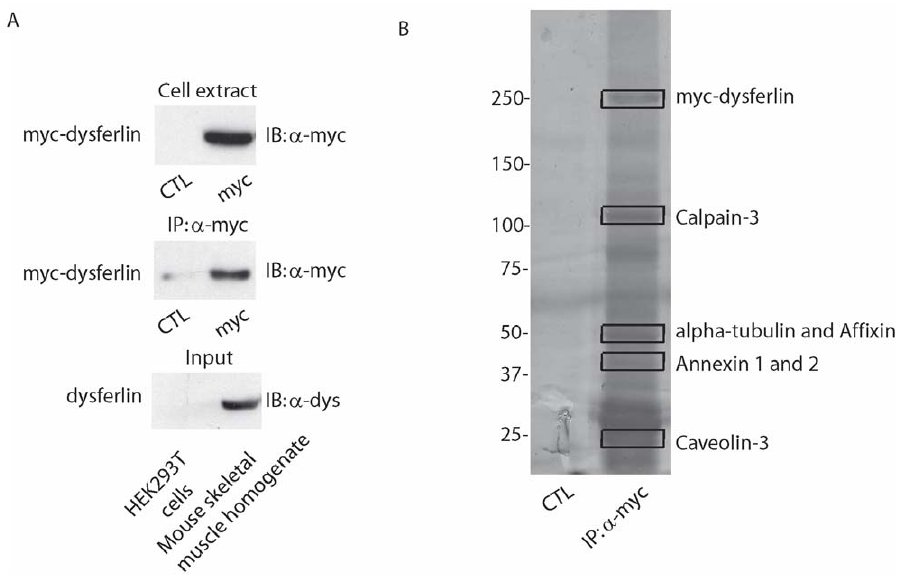
Figure 2. Alpha-tubulin is identified as a dysferlin interacting protein through affinity purification and mass spectrometry analysis. A. Western blot to detect the expression of His-myc-dysferlin in transfected HEK293T cells (top panel), the immunoprecipitated myc-dysferlin (middle panel) and expression of endogenous dysferlin in mouse skeletal muscle homogenate (bottom panel). B. SDS-PAGE resolution of the co-purified dysferlin partner stained with silver nitrate. Left lane is the control, whereby His-myc-dysferlin was not transfected into HEK293T cells. Right lane is the immunoprecipitate with myc-dysferlin. Bands containing alpha-tubulin and previously described dysferlin binding partners are highlighted. IB: Immunoblot, IP: Immunoprecipitation, CTL: control.